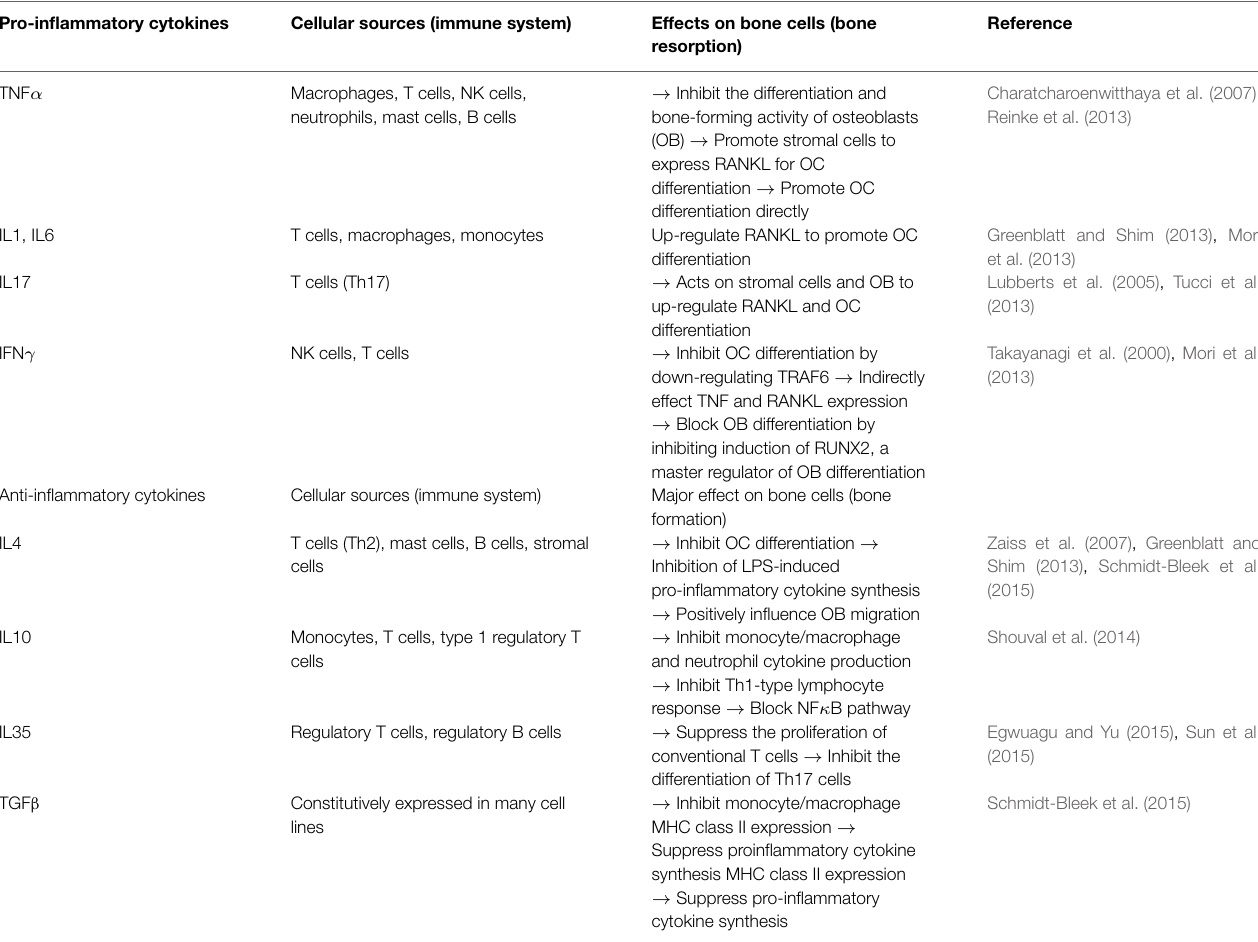
TABLE 3 | Pro- and anti-inflammatory cytokines secreted during tissue repair. Pro-inflammatory cytokines Cellular sources (immune system) Effects on bone cells (bone